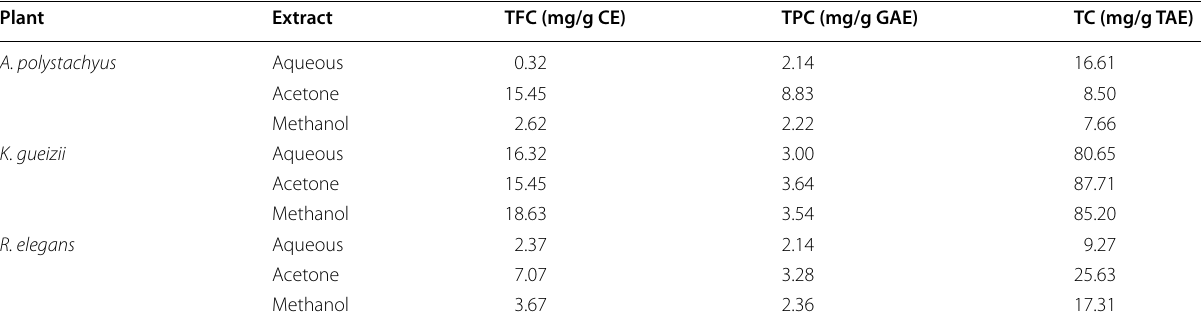
Table 5 Quantitative estimation of phytochemicals responsible for the antimicrobial properties of aqueous, acetone, and methanol extracts of A. polystachyus, K. gueinzii, and R. elegans